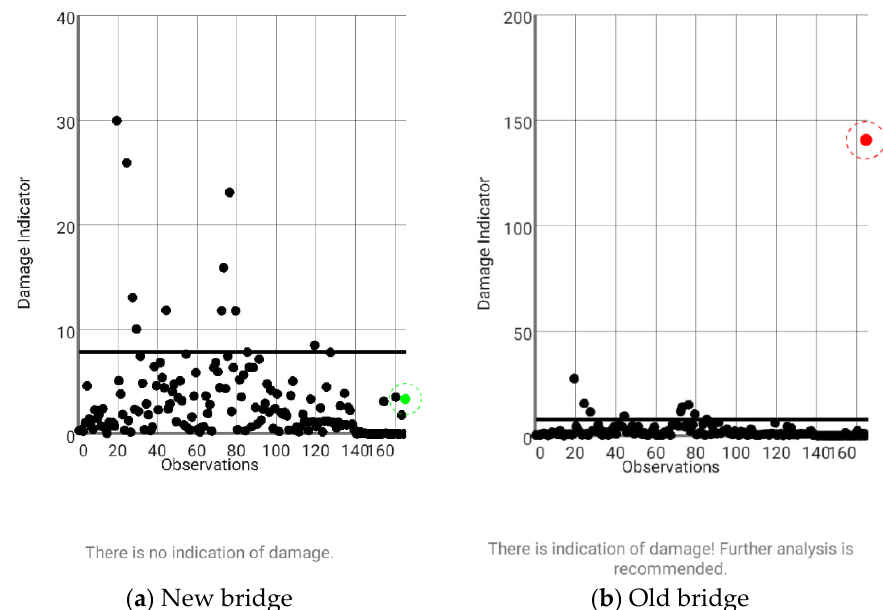
Figure 18. Damage detection at section 5 of new and old bridges using training data from the new bridge only.